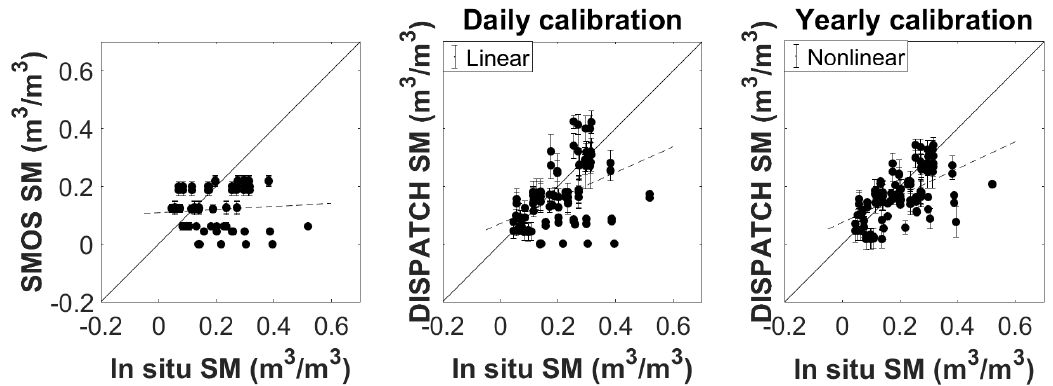
Figure 7. The SMOS and DISPATCH SM are plotted against 1 km aggregated Urgell in situ measurements (for 2015).